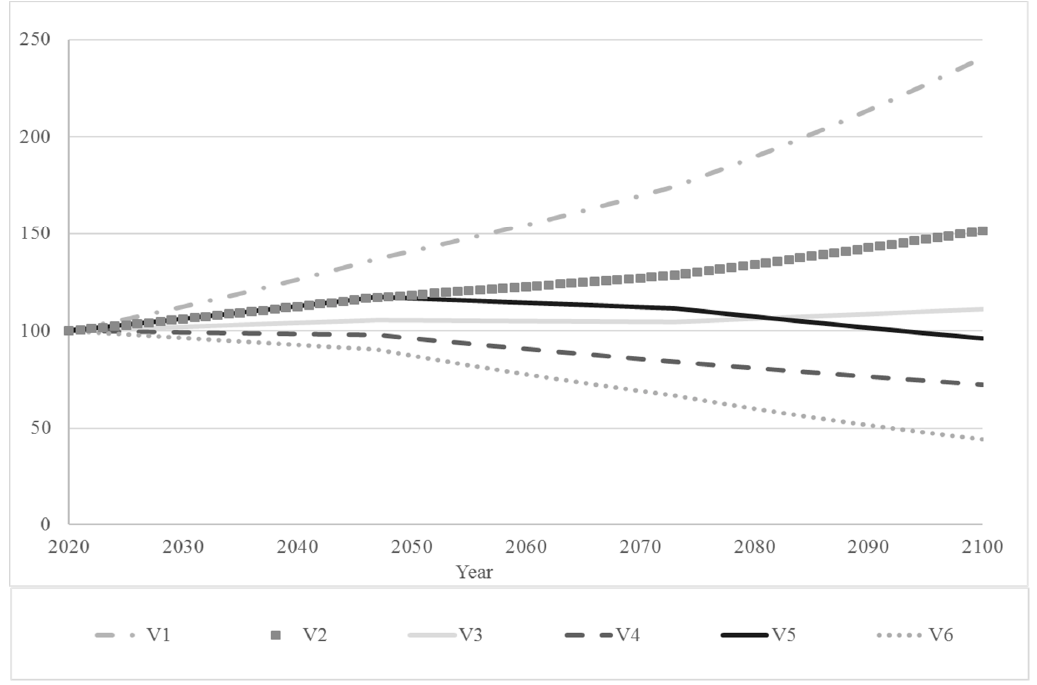
Figure 4. Future trajectories of wastewater flows (index, 2020 = 100). Labels V1 through V6 refer to di ff erent trends of predicted wastewater